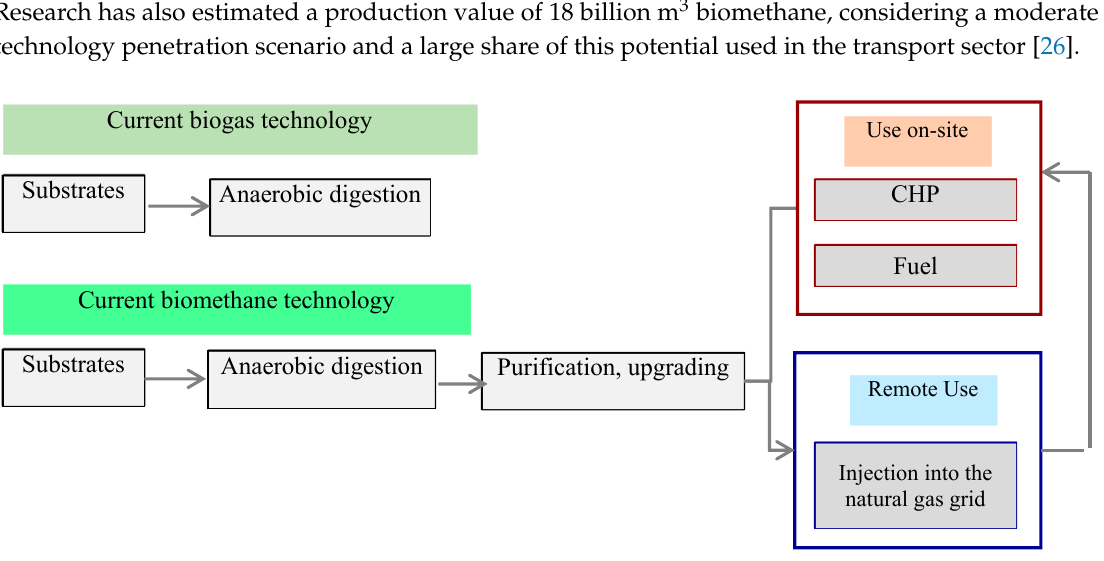
Figure 1. Map of the biogas–biomethane chain. Adapted from the literature [27].